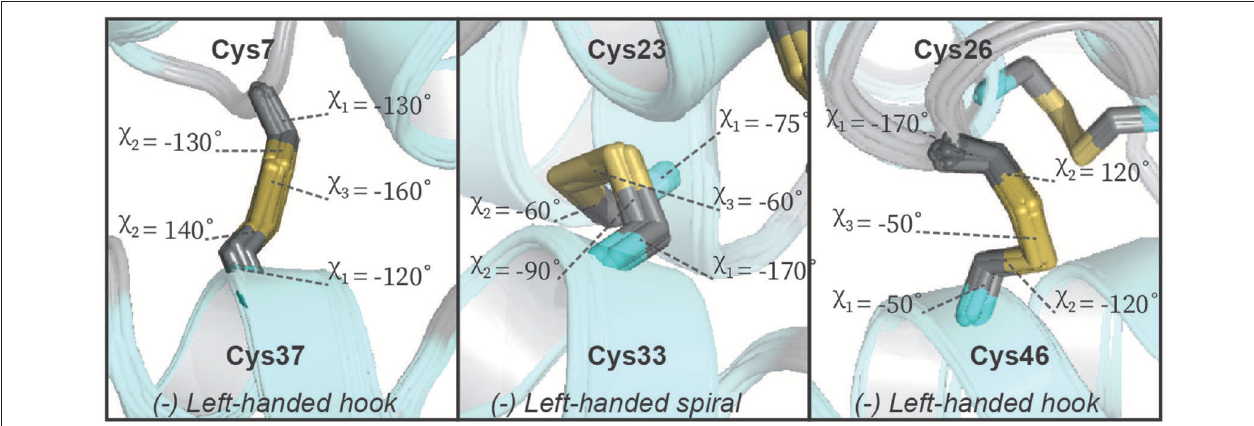
FIGURE 5 | The geometry of the disulfide bonds of Ta1a. Ta1a contains three disulfide bonds, each panel shows expanded regions of the structure focusing on one of these disulfide bonds. The relevant sidechain dihedral angles defining the disulfide bond geometry are shown ( χ 1 , χ 2, and χ 3 ). Two of the disulfide bonds form a left-handed hook while the central disulfide bond forms a left-handed